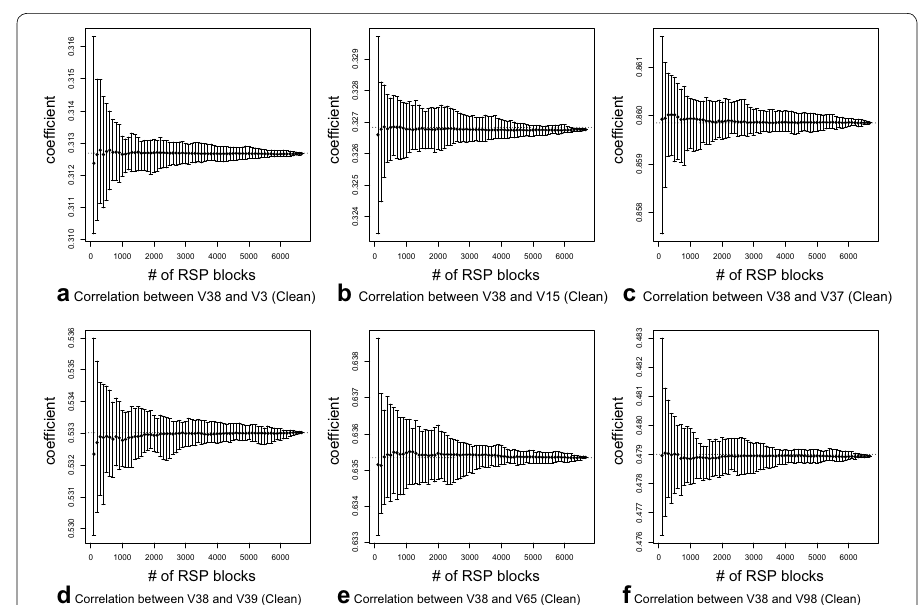
Fig. 13 Correlation between V38 and 6 other features in clean Power data. Incremental estimation of Pearson’s correlation coefficients between V38 and 6 other features using samples of clean RSP blocks of Power data ( g = 100 )